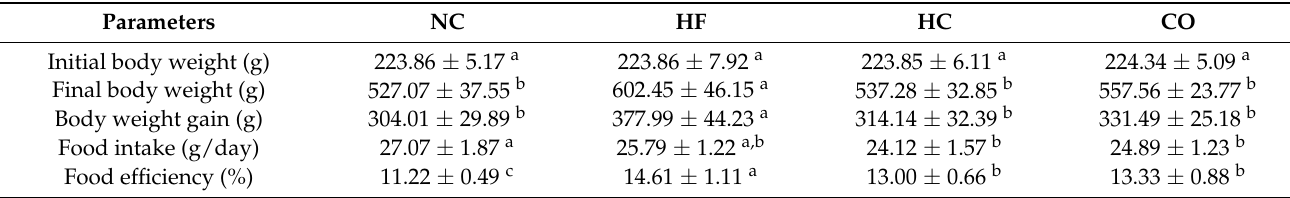
Data are expressed as the mean ± SD for each group ( n = 8). Values with different superscript letters (a, b, c) are significantly different from each other ( p < 0.05). NC: Normal control diet (chow diet). HF: High-fat diet (chow diet + 10% lard). HC: HF diet + 5% high-molecular- weight chitosan. CO: HC diet + 5% chitosan